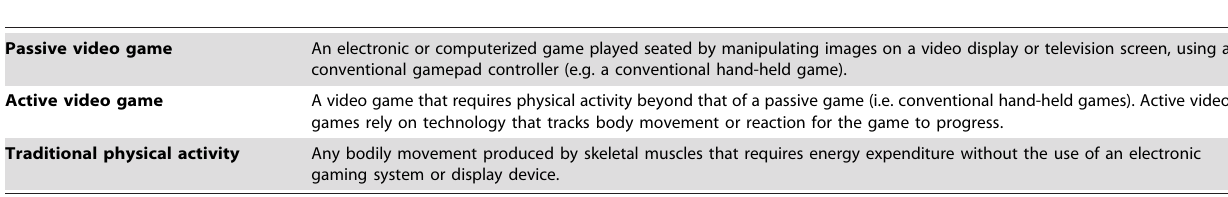
Table 1. Definitions used to guide the systematic